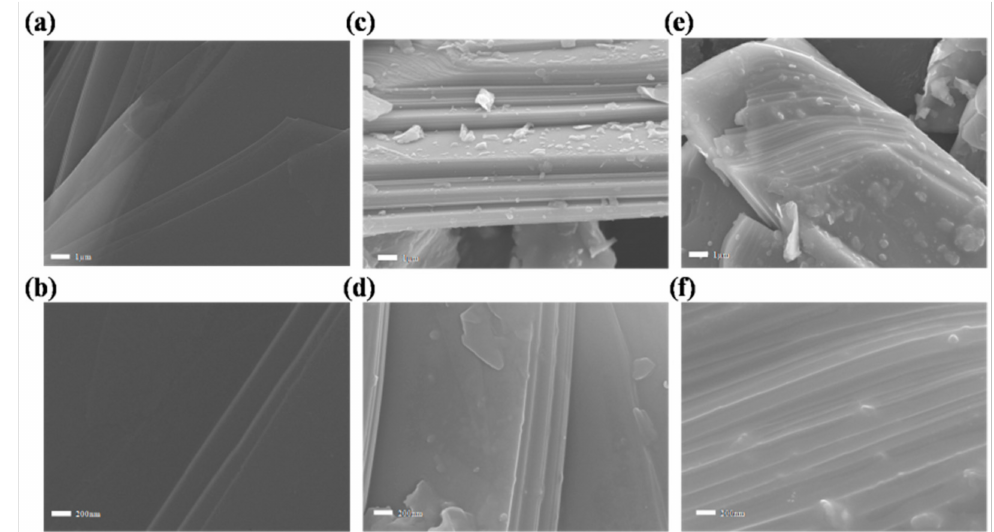
Figure 1. The FE-SEM images of ( a , b ) pure black phosphorus and ( c – f ) after oxygen plasma treatment for ( c , d ) 5 min and ( e , f ) 10